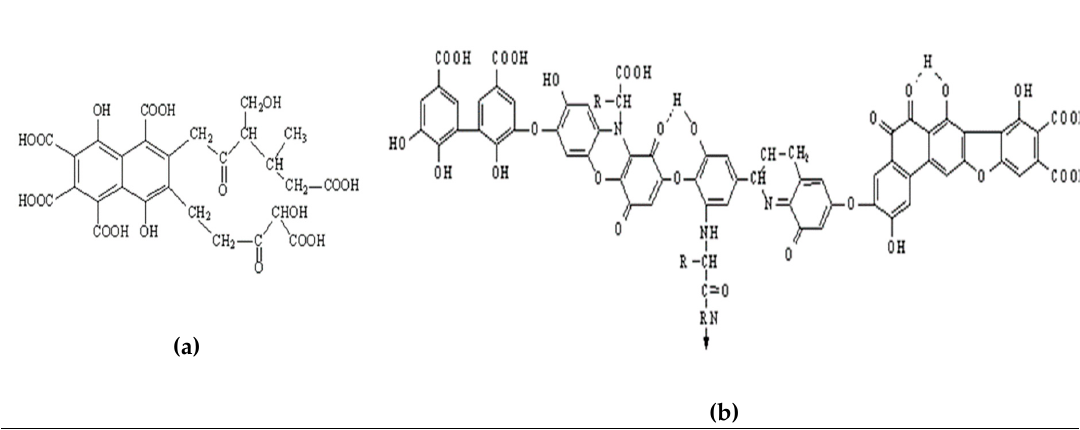
Figure 7. Structural formulas of ( a ) fulvic acid and ( b ) humic acid [12].